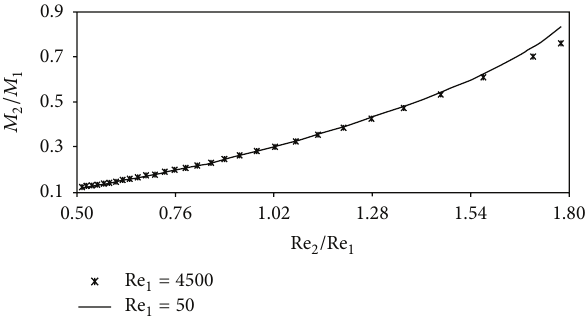
Figure 5: Change of Mach numbers ratio ( 𝑀 2 /𝑀 1 ) as a function of Re 2 / Re 1 for two different Re 1 values.